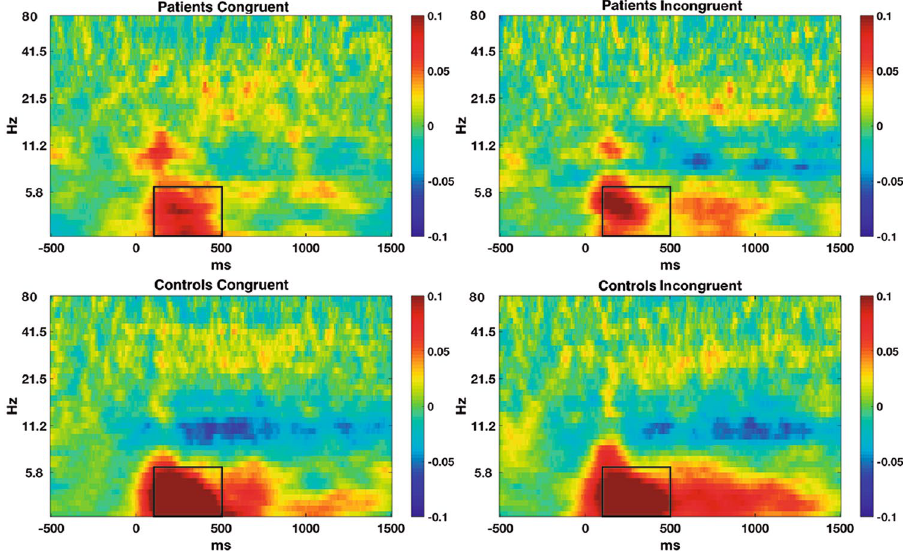
Figure 4. Phase-locking values between midfrontal and posterior locations for each group and condition. Boxes show the windows used for statistical